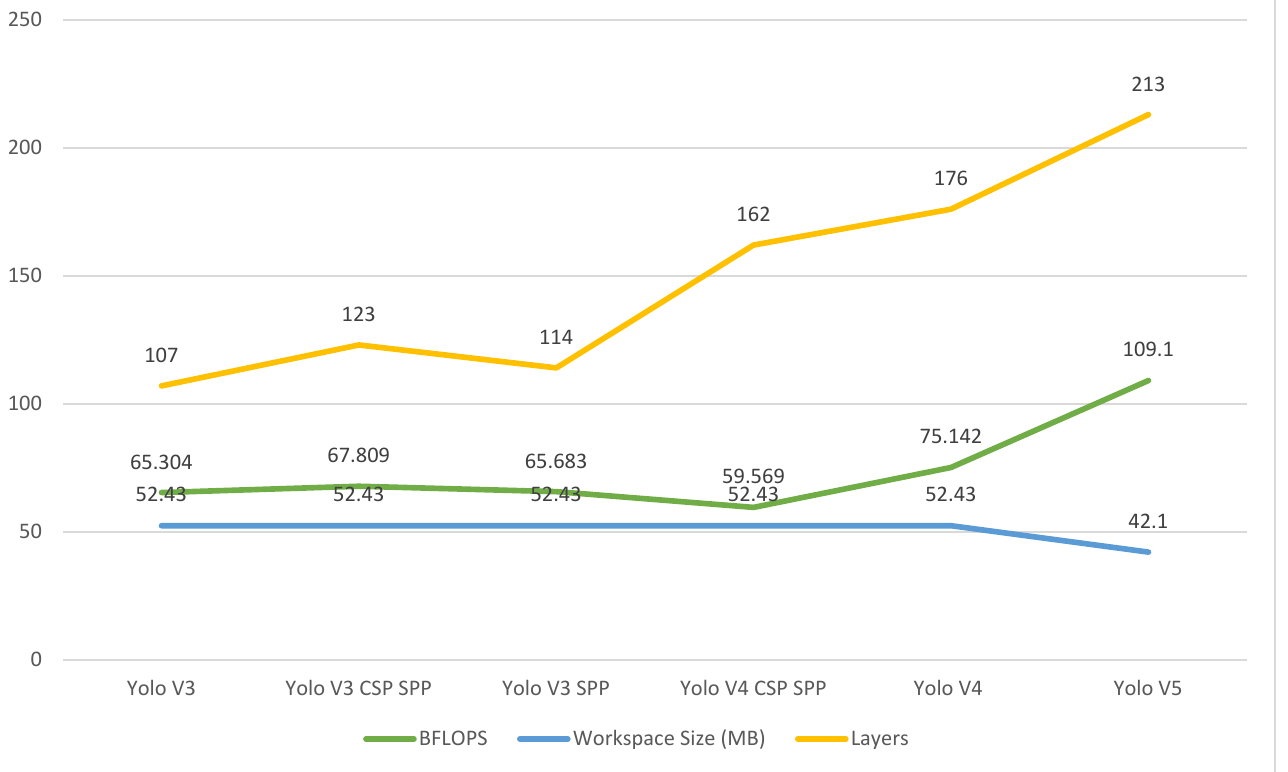
Table 3. Previous research